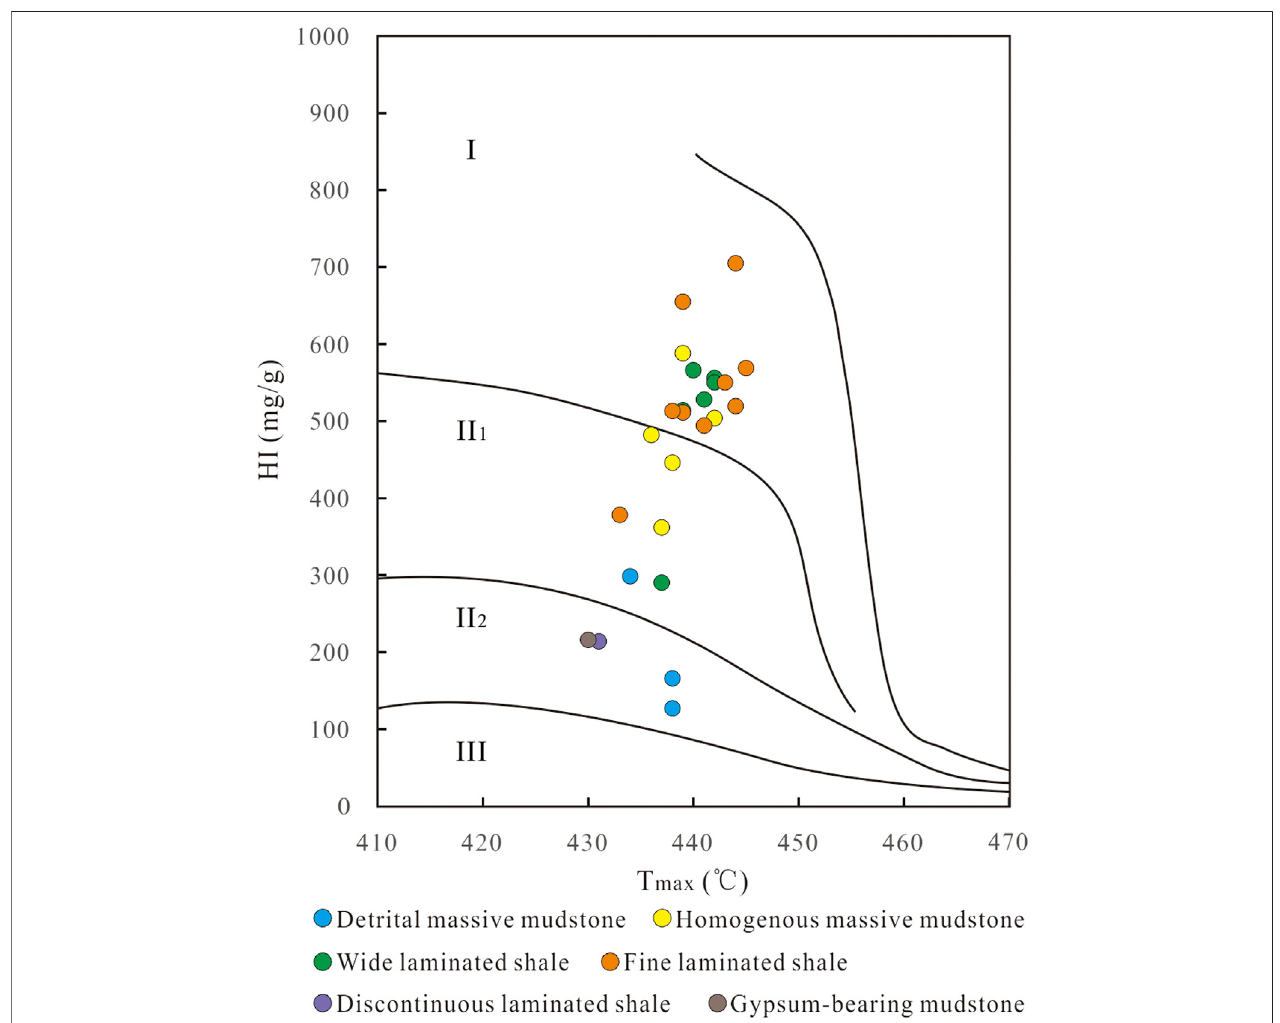
FIGURE 5 | HI versus T max plot showing the OM type of shale with different lithofacies.